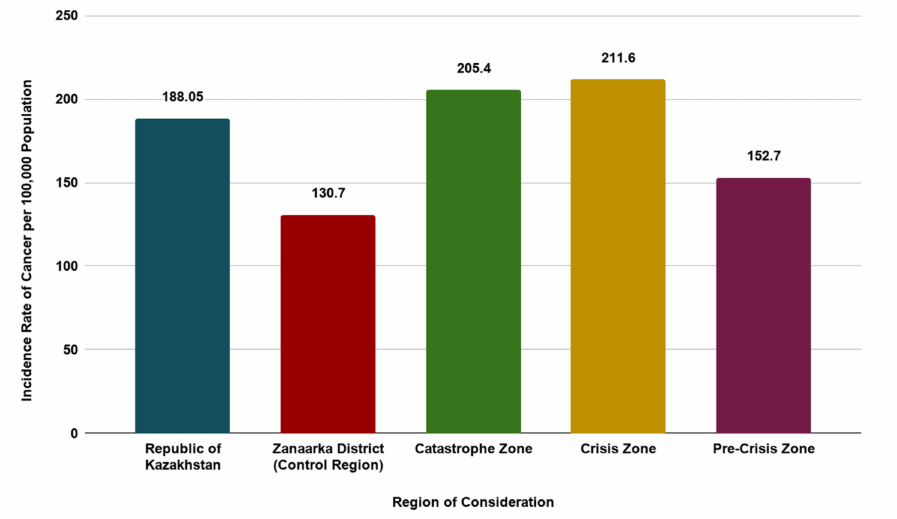
Figure 5. Ten-year annual average of cancer incidence rates 100,000 people for the period 2003–2014